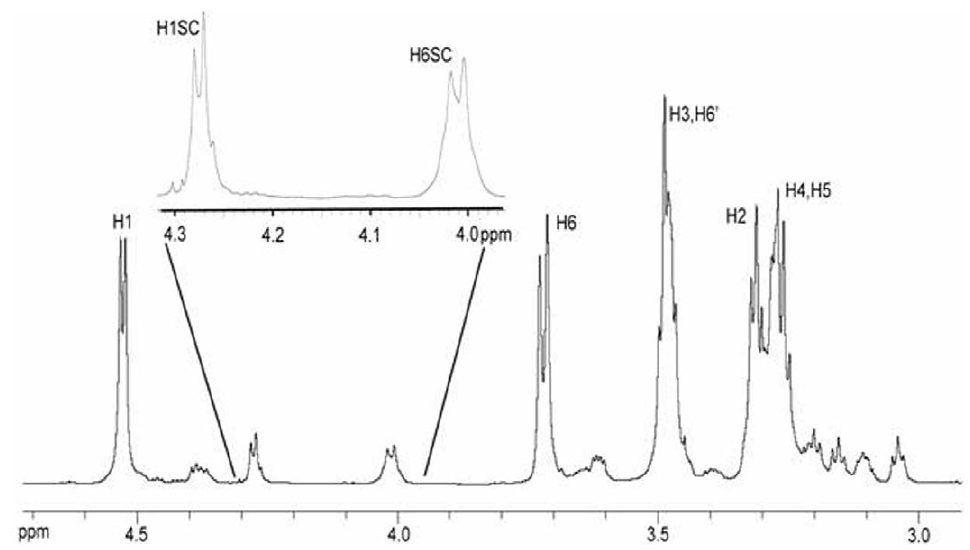
Figure 1. 1D proton NMR spectrum of the (1 R 3,1 R 6)- b -D-glucan isolated from C.glabrataace2 strain. Proton assignments refer to the glucosyl repeat units in the polymer (1 R 3)- b -linked backbone. The expansion of the spectral region from 4.32 to 3.96 ppm shows the multiple inflection points in the resonances for the anomeric proton, H1SC, and one of the methylene protons, H6SC, of the (1 R 6)- b -linkage of the side chain. The resonance line shapes are suggestive for multiple side chain glycosidic bond conformations and/or multiple side chain lengths. The doublet resonance at 4.30 ppm results from the anomeric proton of b -glucose.